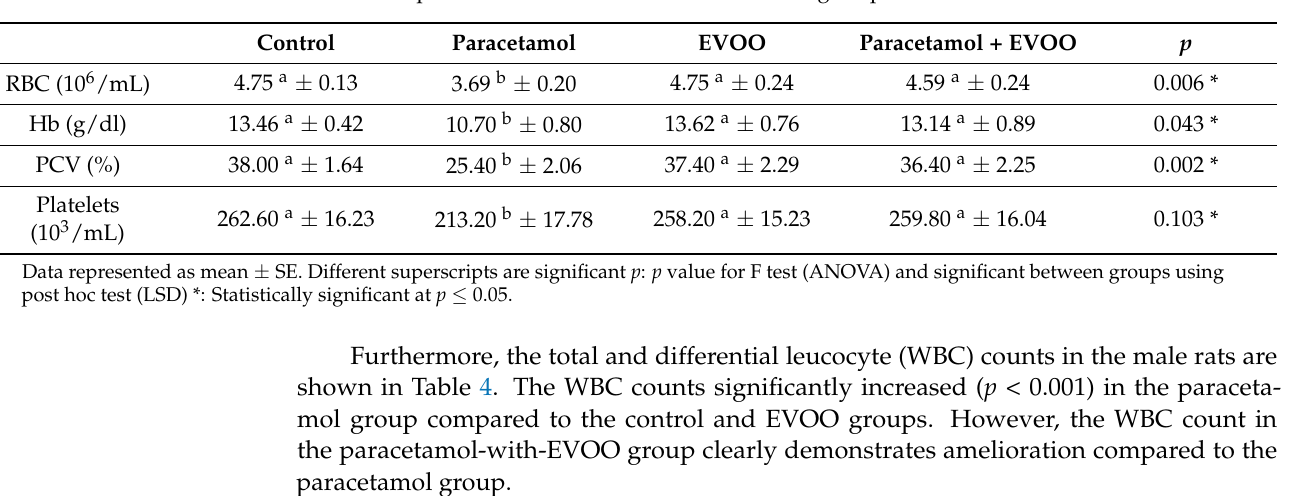
Figure 10. Effect of administration of paracetamol and/or EVOO on testosterone. Table 3. Effect of administration of paracetamol and/or EVOO on hematological parameters in male Wistar rats.